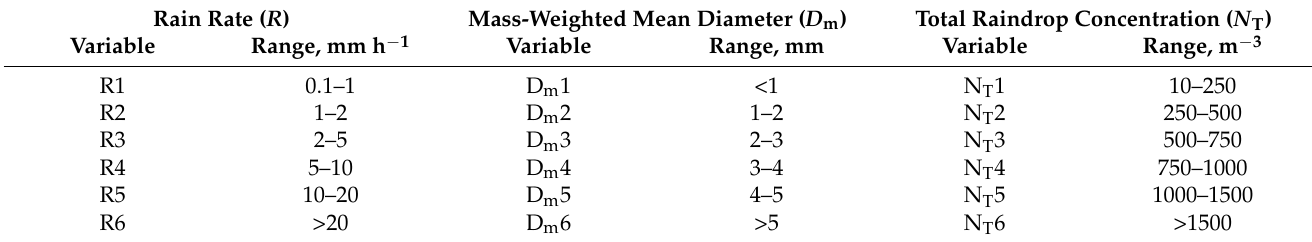
Table 2. Categories of rain rate ( R ), mass-weighted mean diameter ( D m ) and total raindrop concen- tration ( N T